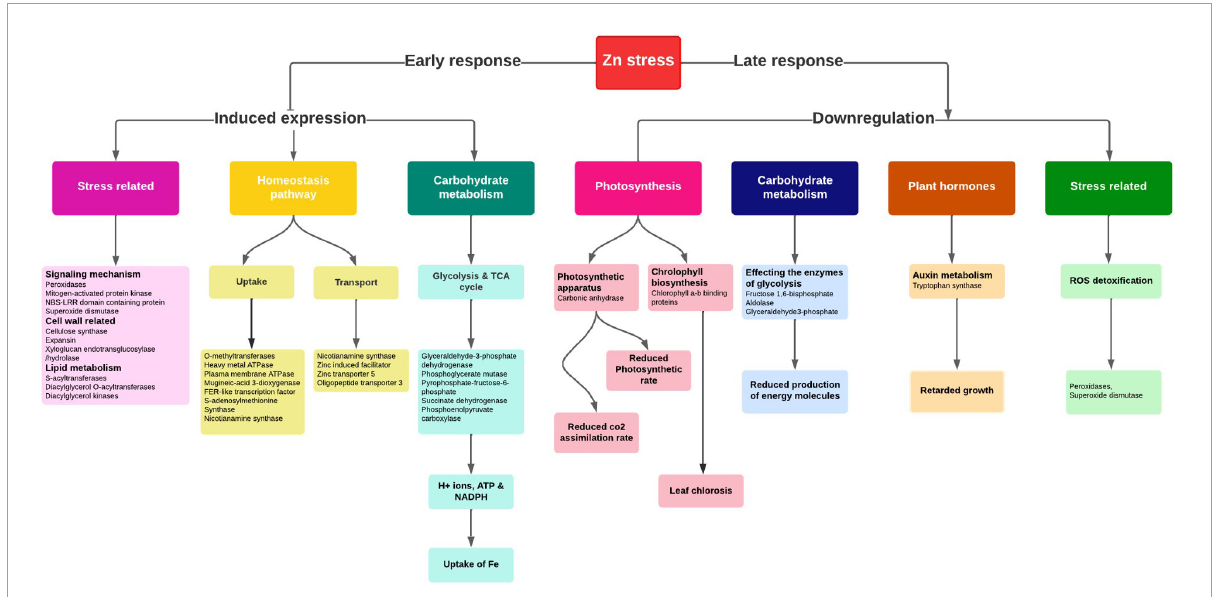
FIGURE7 Important pathways and their interconnectivity in response to Zn stress in pearl millet.